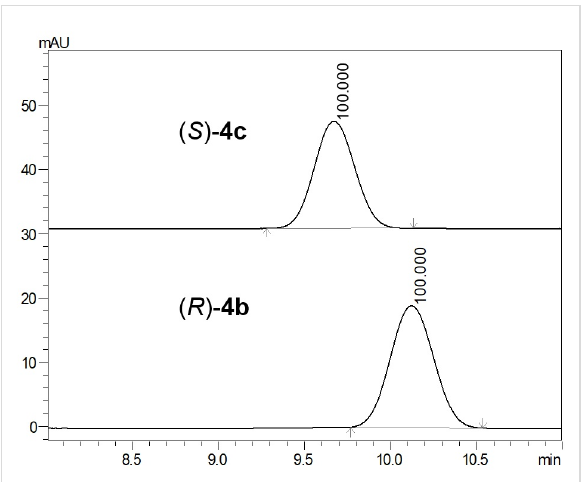
Figure 3: Stacked chromatogram view of pairs of enantiomers with area, %: ( R )- 4b , ee 100% ( t R = 10.1 min) and ( S )- 4c , ee 100% ( t R = 9.6 min); conditions: CHIRAL ART Cellulose-SB (100 × 4.6 mm I.D., S-3 µm, chiral selector cellulose tris(3,5-dimethylphenylcarba- mate), YMC); mobile phase: ACN/(H 2 O + 0.1% HCOOH (30:70 isocratic mode); T = 36 °C; flow rate 1.0 mL/min. Samples were pre-